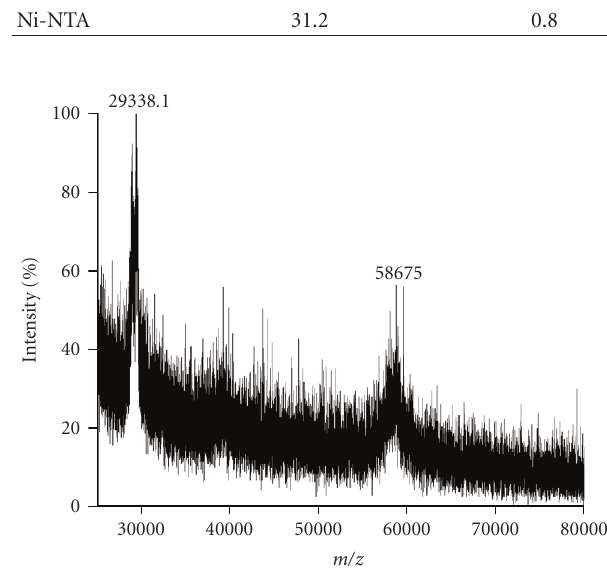
Figure 3: Mass spectometry. MALDI-TOF/MS spectrum of recom- binant urate oxidase using sinapinic acid as matrix showed two related ions for the same polypeptide chain, M+2H + = 29338.1 Da and M+H + = 58675